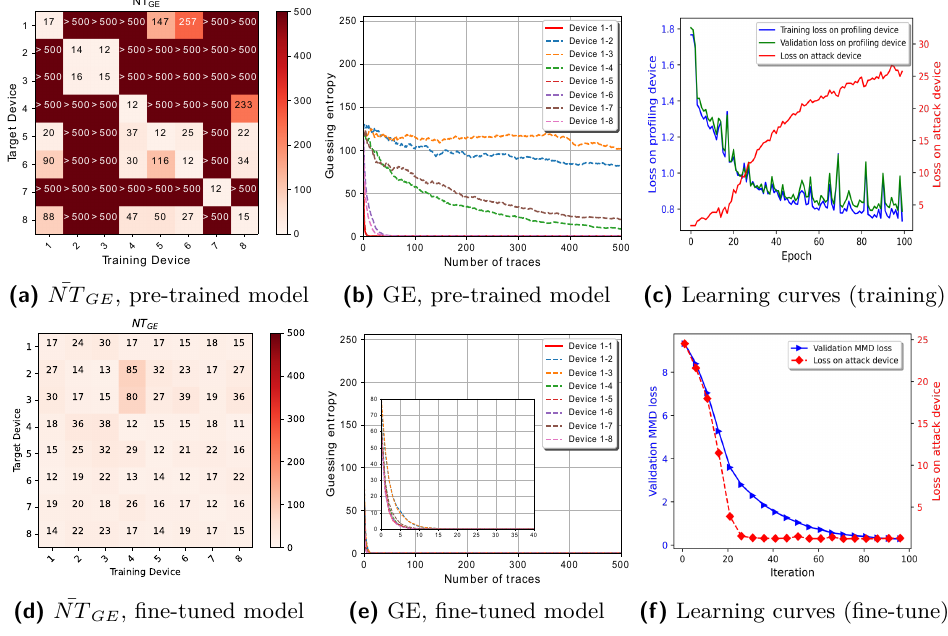
Figure 8: Results on